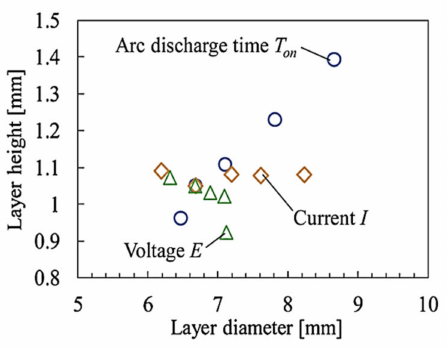
Figure 7. Influence of process parameters on layer geometry. Reprinted from Ref.